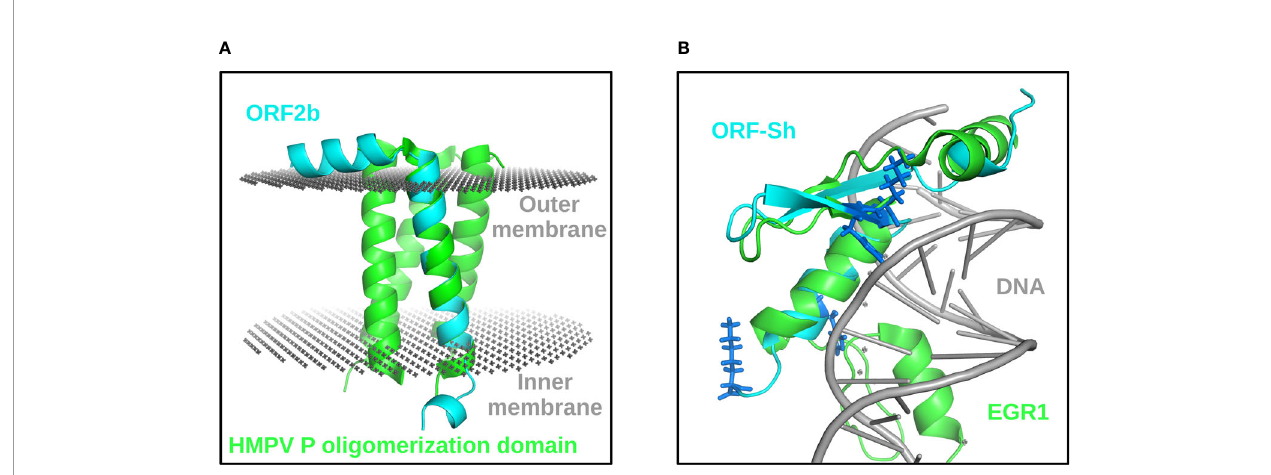
FIGURE 1 | Structural characterization of ORF2b and ORF-Sh. Full-length ORF2b (cyan) aligned with one protomer of the HMPV P oligomerization domain (green) fi xed in a bilayer membrane (gray) is depicted (A) . ORF-Sh (cyan) aligned to the mouse early growth response protein 1 (EGR1) (PDB: 1p47) (green), which is a homolog of transcriptional repressor CTCF, bound to DNA (grey) is shown (B) . Basic residues in the ORF-Sh protein are shown as dark blue sticks (B)